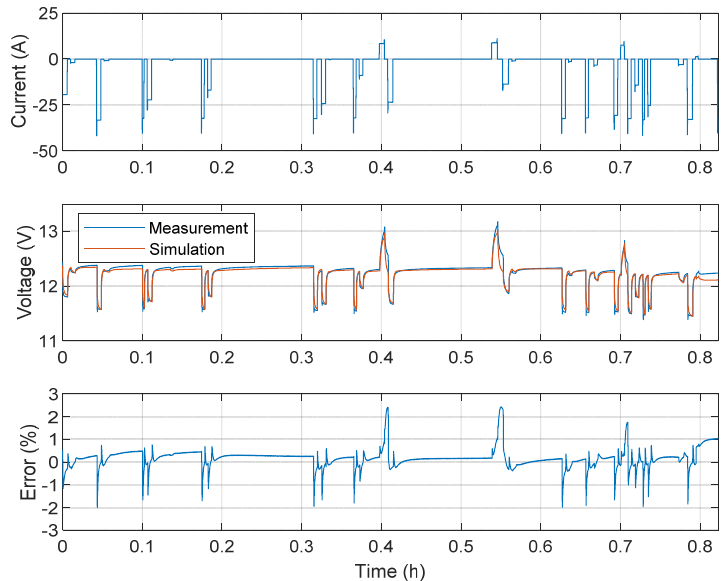
Figure 13. New lead-acid battery validation test (100% SOH).